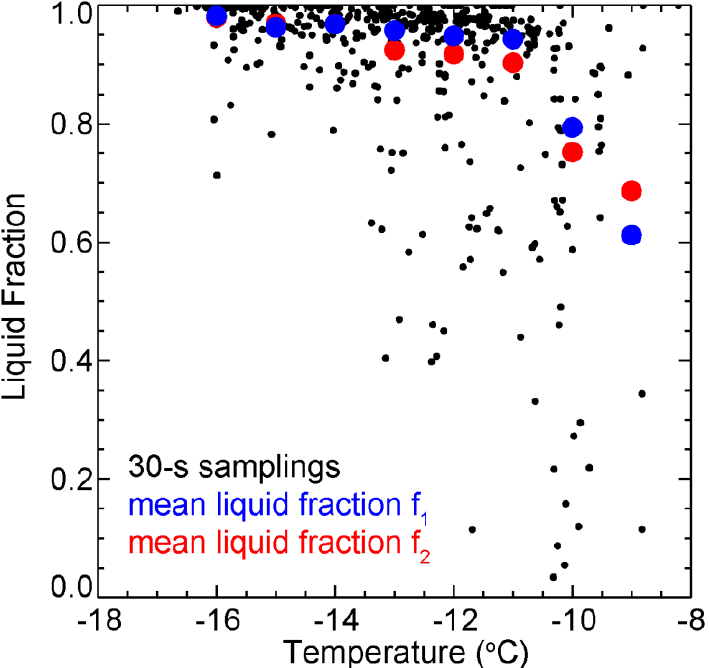
Figure 6. Liquid fraction in the mixed-phase stratiform cloud sampled at NSA site by UND Citation aircraft on 9, 10, and 12 October 2010. The black dots indicate the 30-s samplings, and the big blue and red dots indicate the mean liquid fractions calculated using Equations (1) and (2), respectively.